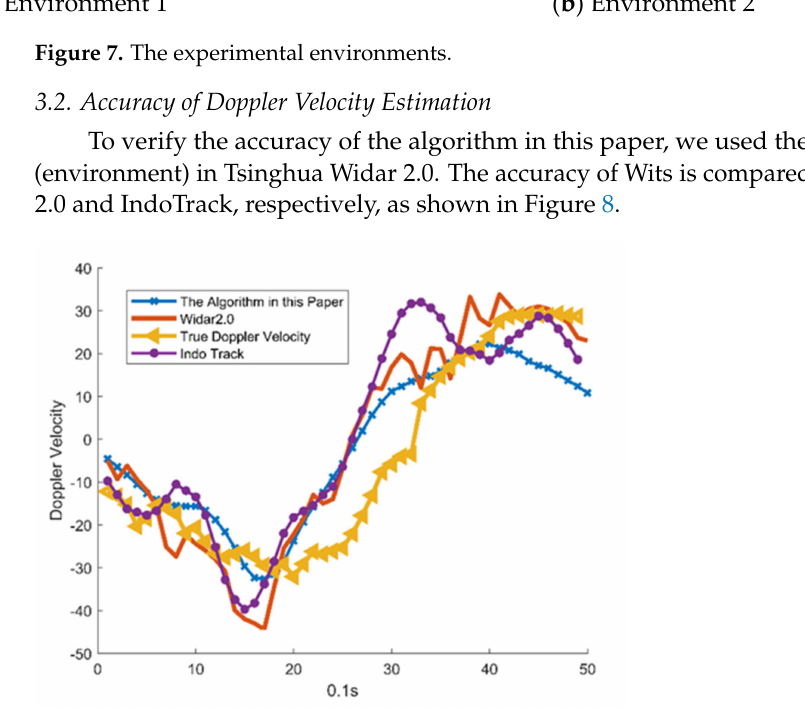
Figure 8. Comparison of Doppler velocities of different algorithms.